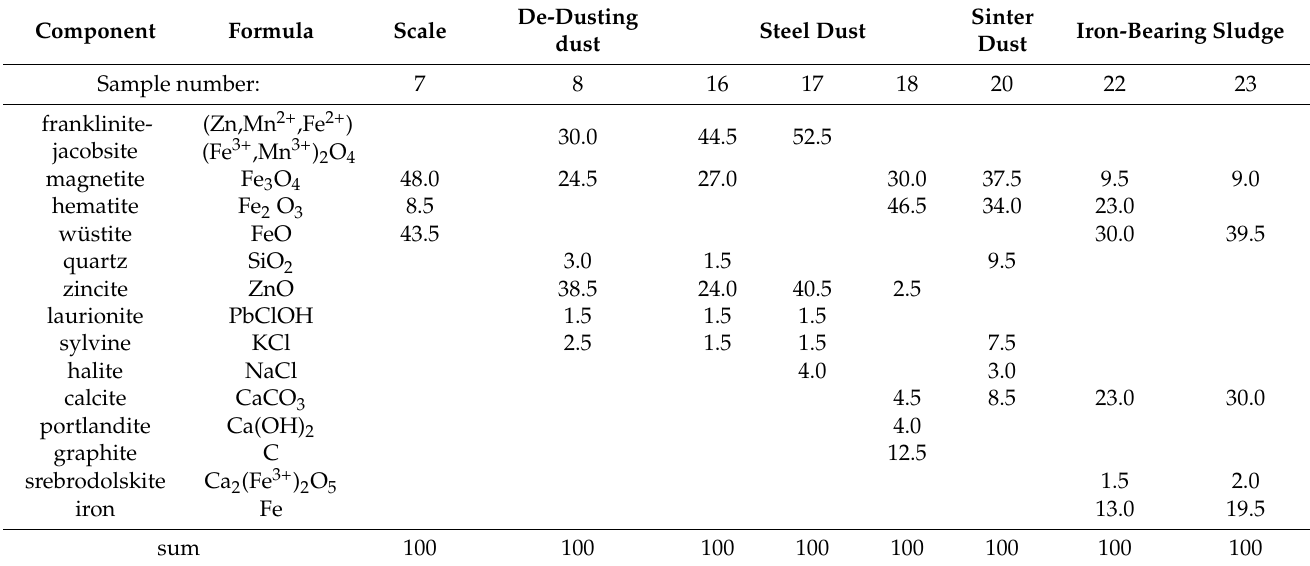
Table 2. Mineral composition of dust from iron smelting processes on the basis of XRD analyses by the Rietveld method in wt%. Component Formula Scale